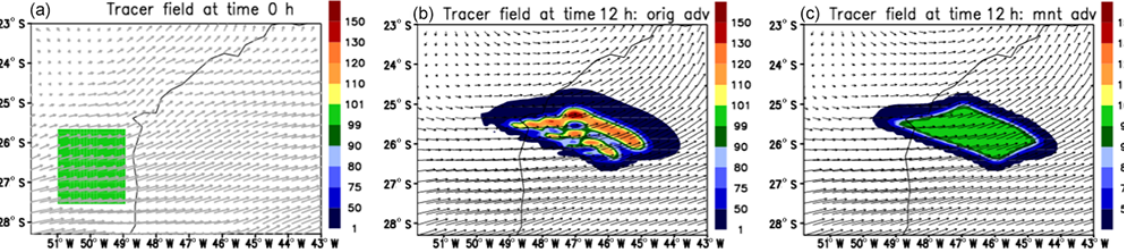
Figure 1. A 3-D hypothetical case study: transport of a rectangular parallelepiped by a realistic divergent flow over the southeastern part of Brazil. (a) The tracer concentration field expressed in terms of the mass mixing ratio at initial time and 1900m height; the horizontal wind flow is also depicted. (b, c) The correspondent mass mixing ratio after 12h as simulated by the original and monotonic advection schemes,